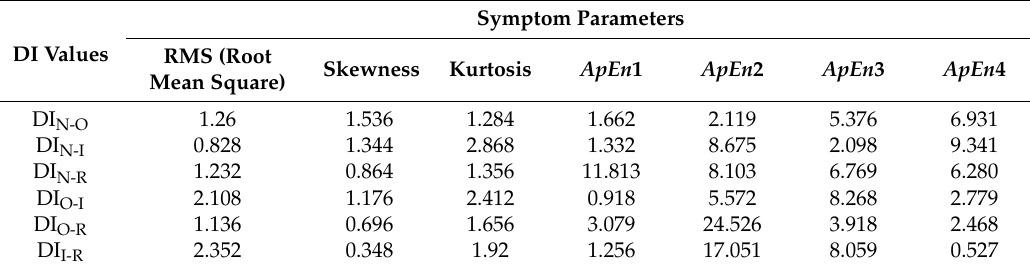
Table 3. Distribution information of the ApEn .